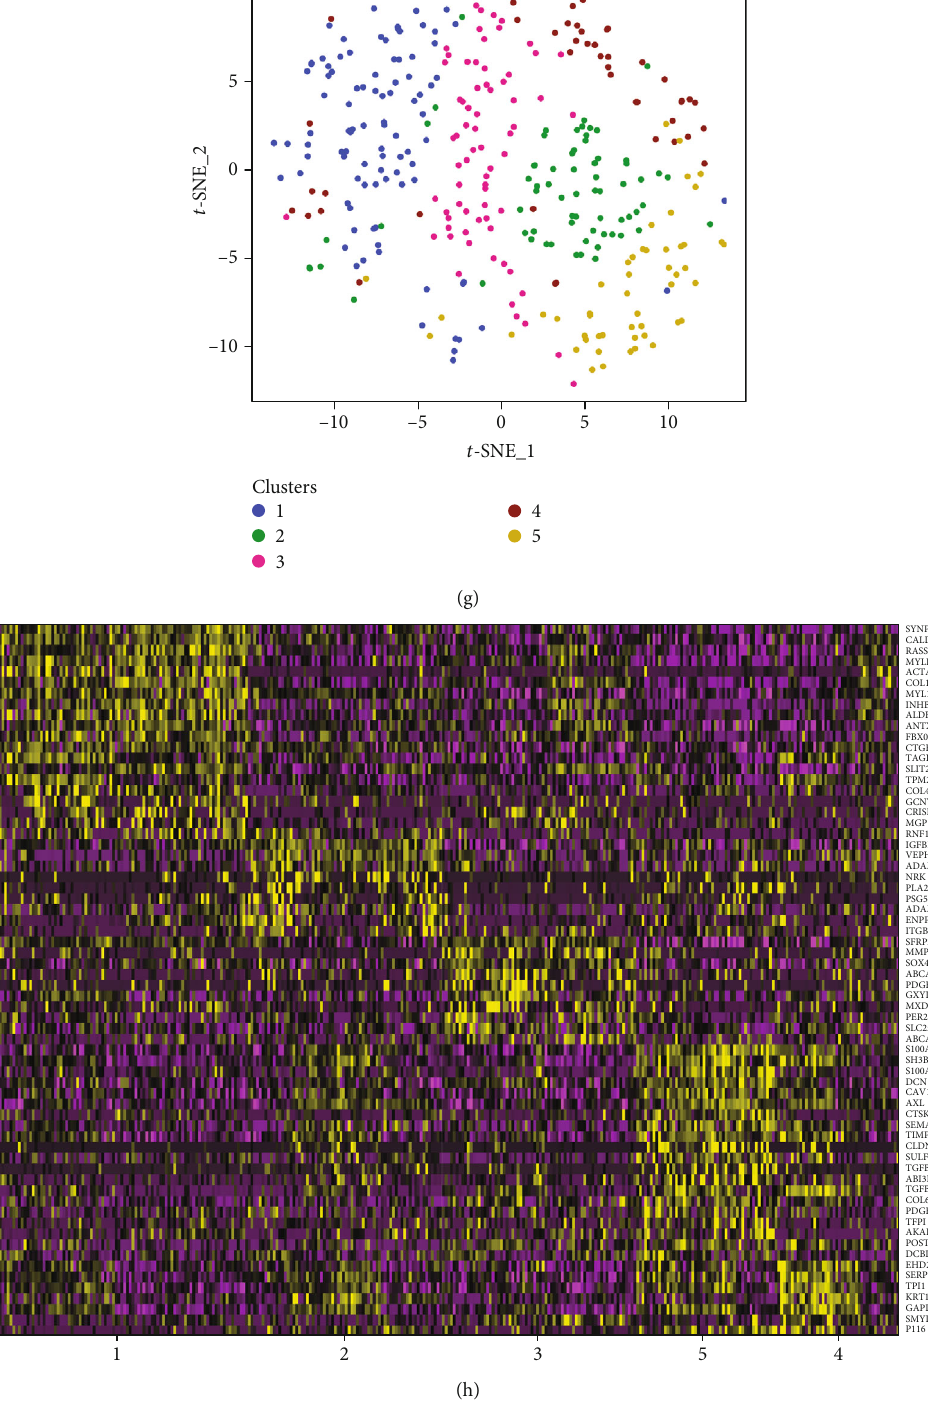
Figure 1: t -SNE plots illustrating the di ff erent cluster number permutations and heatmaps illustrating the top DEGs for each cluster. The colored dot clouds on the tSNE plots represent individual clusters. (a) Two clusters were identi fi ed at resolution 0.5 while (c) three clusters were identi fi ed at resolutions 0.6 and 0.7. (e) Four were identi fi ed at resolution 0.8 and (g) resolution 0.9 to 1.2 consistently identi fi ed fi ve clusters. For each cluster number permutation, there is a corresponding heatmap illustrating the top DEGs per cluster (two, three, four, and fi ve clusters, respectively). Yellow represents highly expressed genes while purple represents poorly expressed